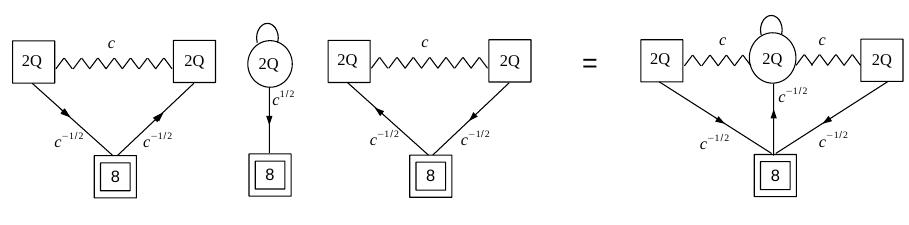
Figure 10: Gluing two basic tubes together with a trivial element of the Weyl